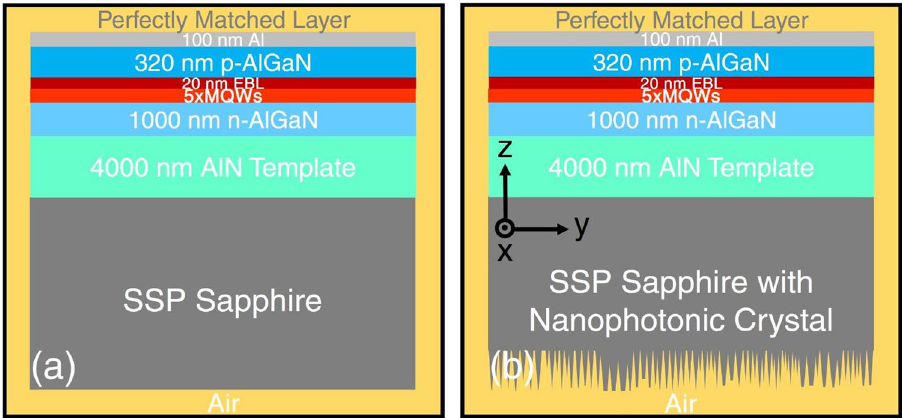
Figure 5. Schematic illustration of the simulated model DUV-LED devices with NPhC ( b ) while the model for the conventional DUV-LED device is almost the same except the sapphire substrate without NPhC ( a ).